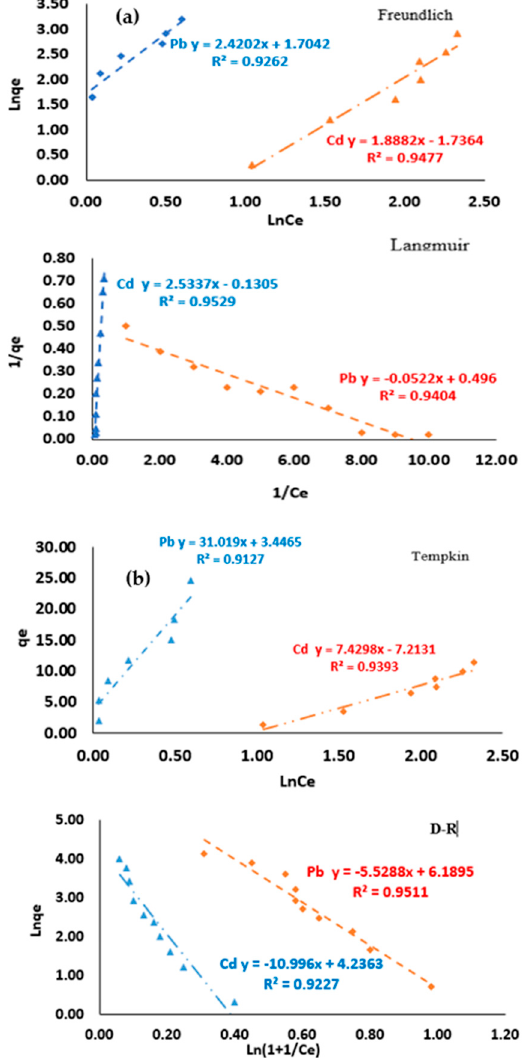
Figure 8. ( a ) Freundlich and Langmuir isotherm plot ( b ) Tempkin model and D–R plot for Cd 2+ and Pb 2+ adsorption on the Nano-ZnO at room temperature.